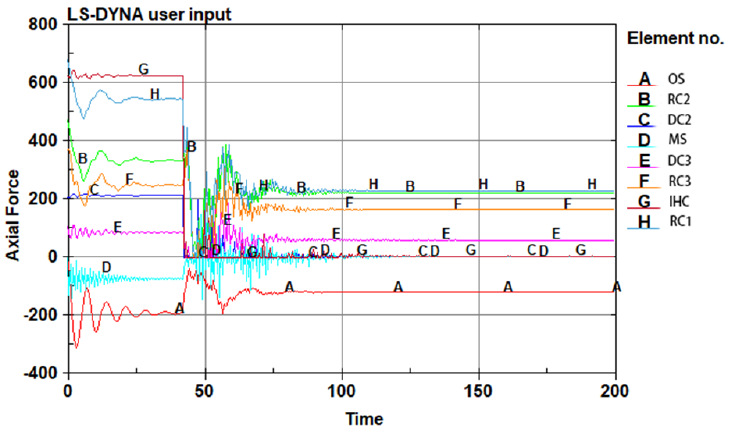
Figure 5. Variations in the internal force with